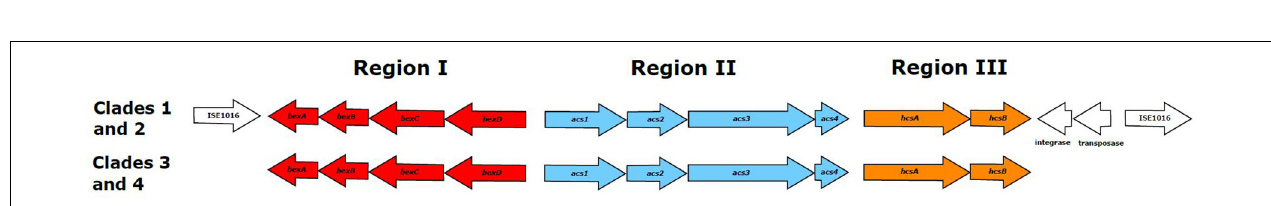
FIGURE 3 | The capsule regions for Hia isolates belonging to each of the four clades is shown. Clades 1 and 2 contain genes encoding an integrase and transposase proteins and are flanked by IS1016 elements.